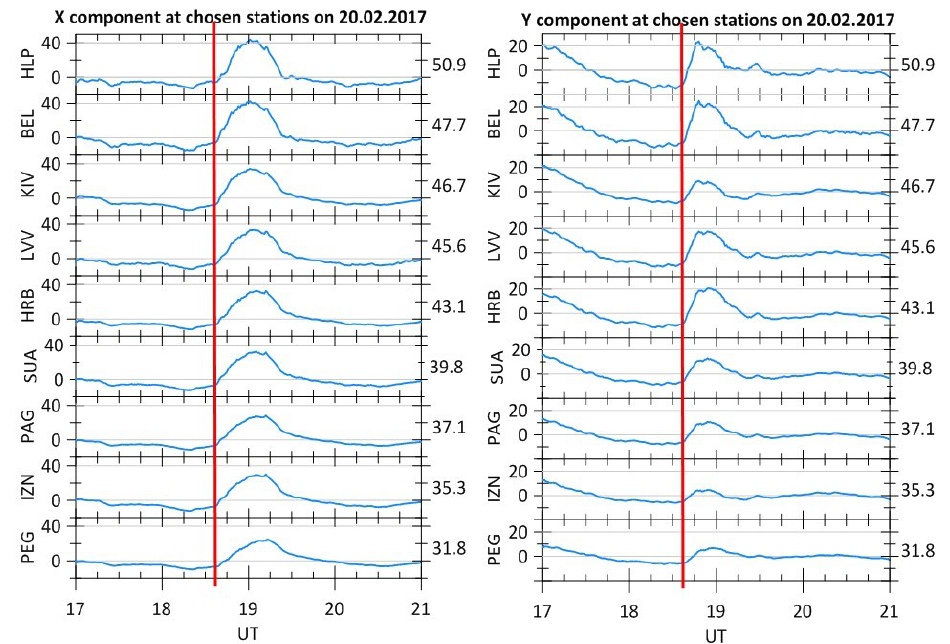
Fig.4. X (left panel) and Y (right panel) magnetic components at chosen INTERMAGNET stations from 17 UT to 21 UT on 20 February 2017.